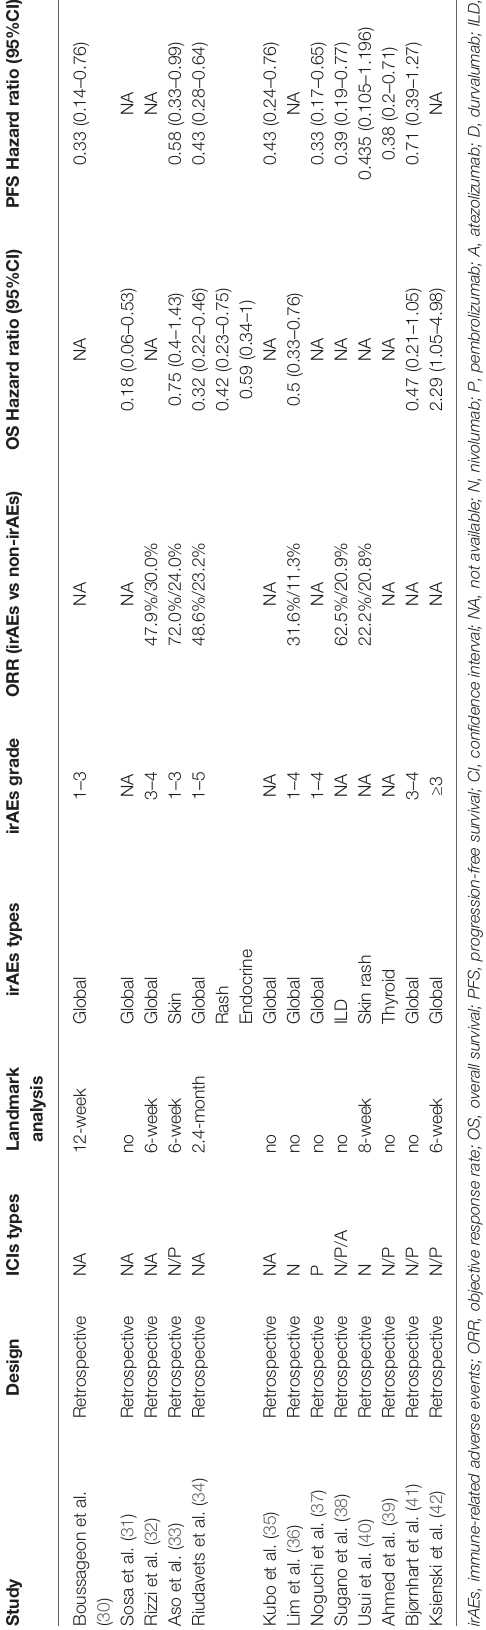
0.18) for pembrolizumab monotherapy ( Supplementary Material 1: Figure S4